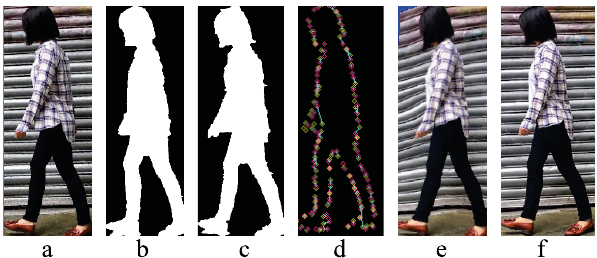
Fig. 10 Comparison with warping with matched shape contour. (a) Input frame from video V 1 . (b) Mask for video V 2 . (c) Input Mask for video V 1 . (d) Shape-Context matching result. Blue lines show the correspondences. (e) Warped result using contour matching. (f) Our